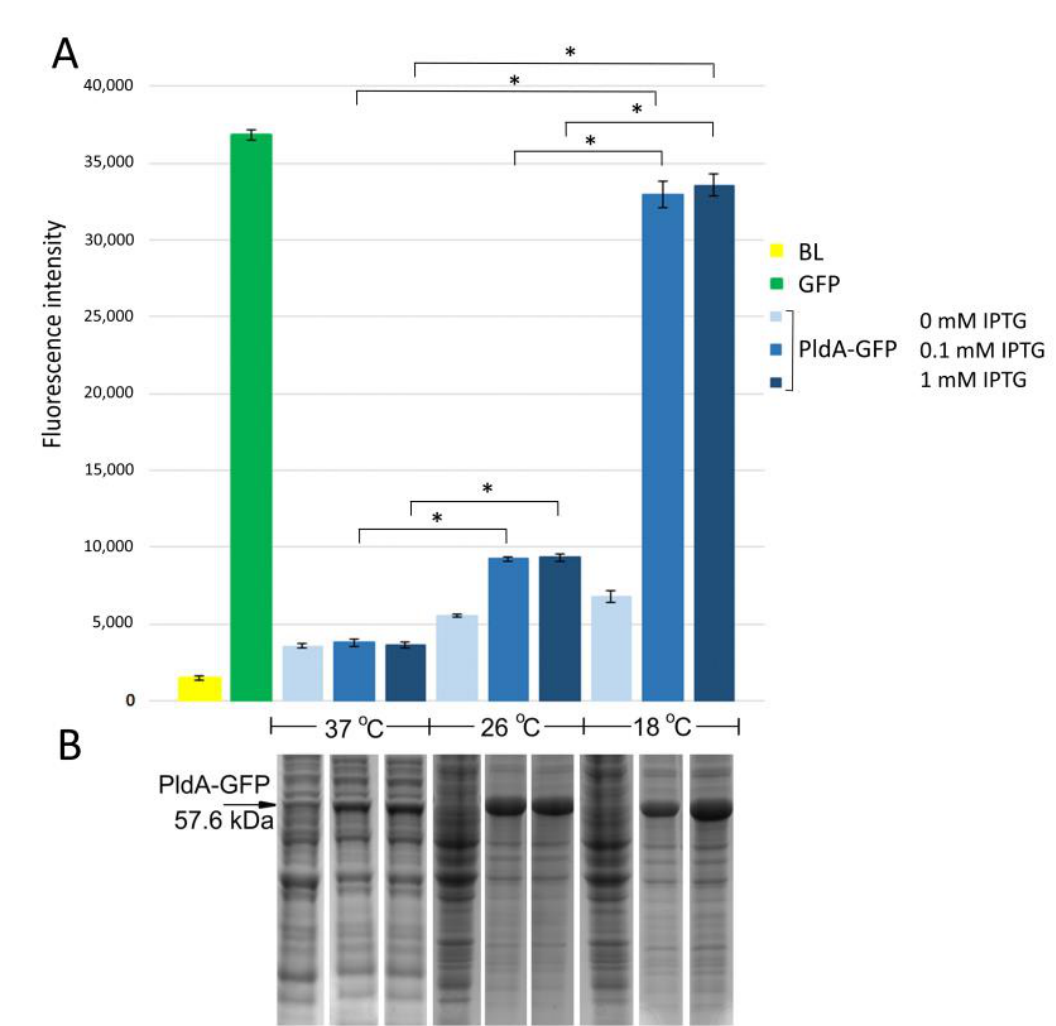
Figure 1. The level of GFP fluorescence in E. coli cells ( A ) and the expression of PldA-GFP fusion protein ( B ) in E. coli cell lysates after 16 h of incubation at different cultivation temperatures and IPTG concentrations. BL—plasmidless cells (negative control); GFP—cells expressing GFP protein (positive control). Fluorescence and bacterial mass for cell lysates were normalized according to OD 600 . The experiments were performed in three biological replicates. Results show the mean ± standard deviation (SD). The asterisk (*) indicates a significant difference ( p -value < 0.05) in the fluorescence level between indicated groups.